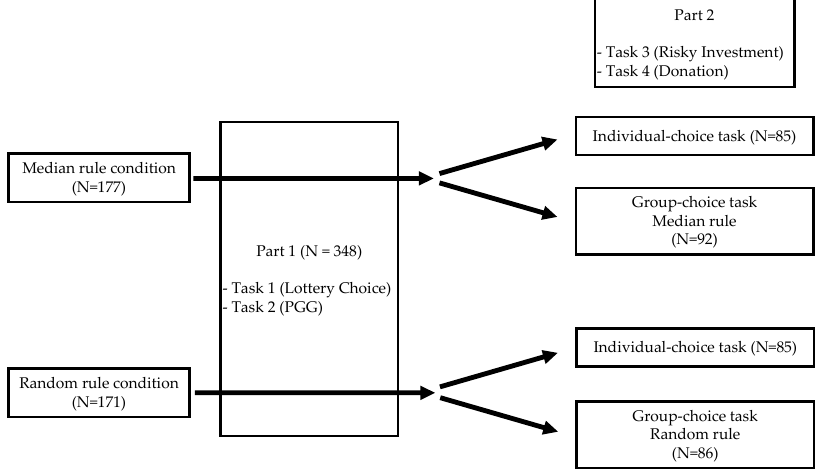
Figure 1. Our experimental design.